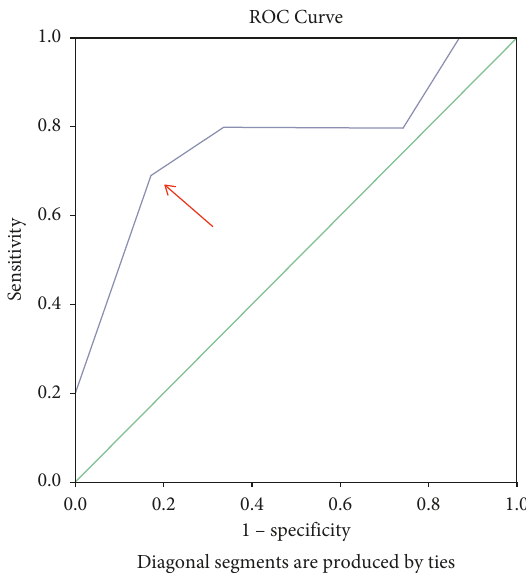
Figure 2: ROC curve 2 shows where to determine the cutoff for difficult and very difficult